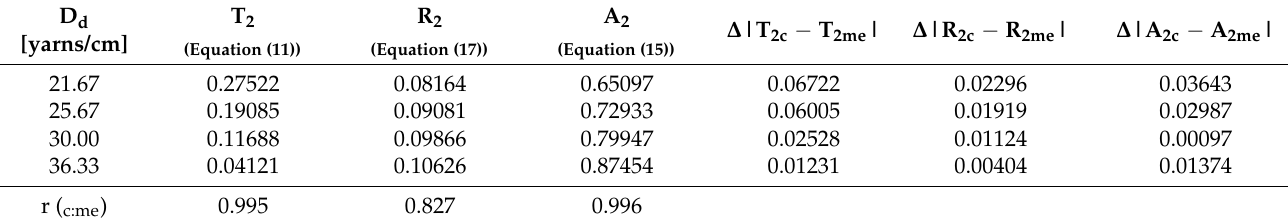
Table 6. Calculated values ( c ) of UV parameters double- (T 2 , R 2 , A 2 ) layered CO samples and the absolute values of their differences compared with measurement ( me ) values and the conformation of their connections with the coefficient of correlation.